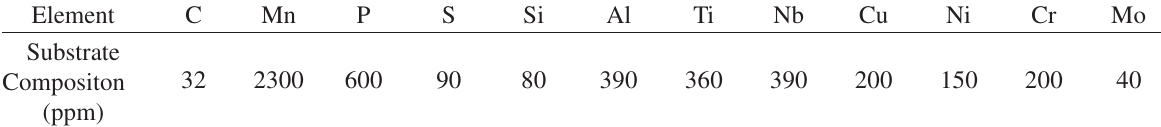
Table 1. Chemical composition of the galvanized steel sample (information provided by the sample supplier).